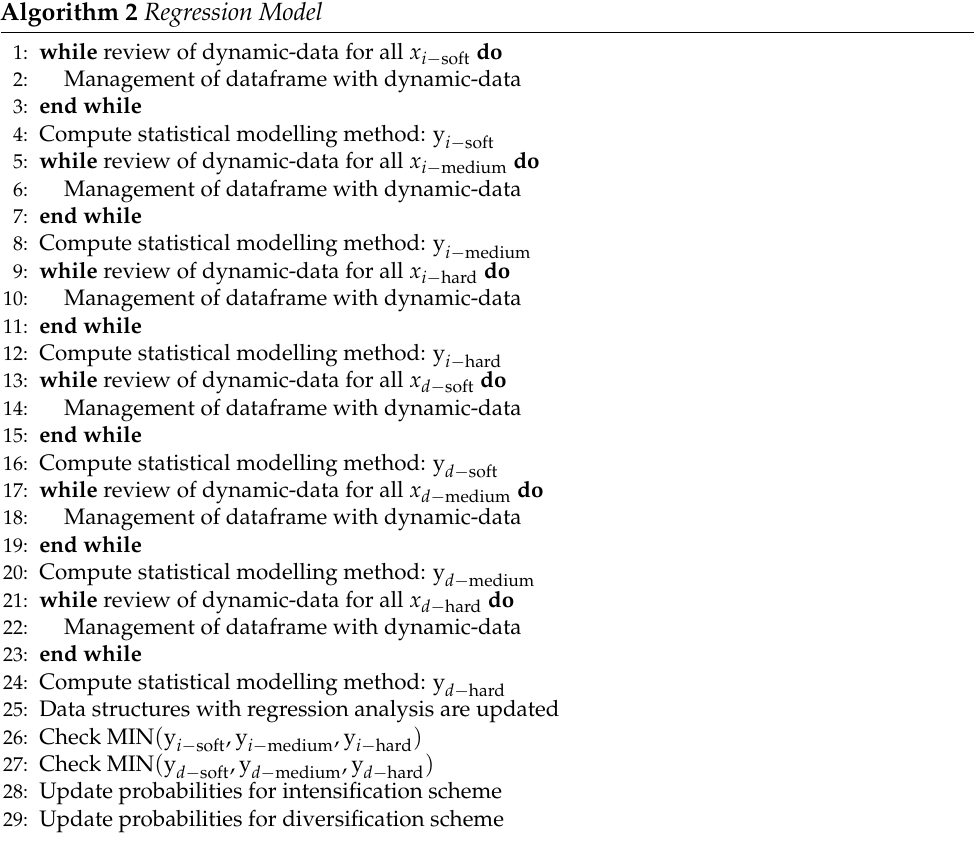
Algorithm 2 Regression